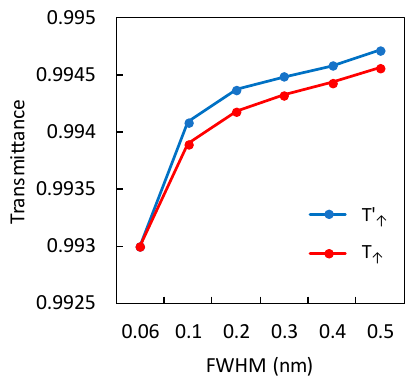
Figure 11. Upward atmospheric transmittances at 760.6 nm from MODTRAN simulations with different FWHM. The red points ( T ↑ ) are transmittances calculated as < L sensor / L canopy >, and the blue points ( T (cid:48) ↑ ) are transmittances calculated as < L sensor >/< L canopy >. <> represents convolution with ISRF. The original FWHM of MODTRAN simulation is 1 cm − 1 (about 0.06 nm at 760 nm), and the ISRF were modelled using Gaussian functions with different FWHM. The atmospheric profile is mid-latitude summer, AOD is 0.1, VZA is 25°, sensor’s height is 25 m, and surface altitude is 1.5 km.